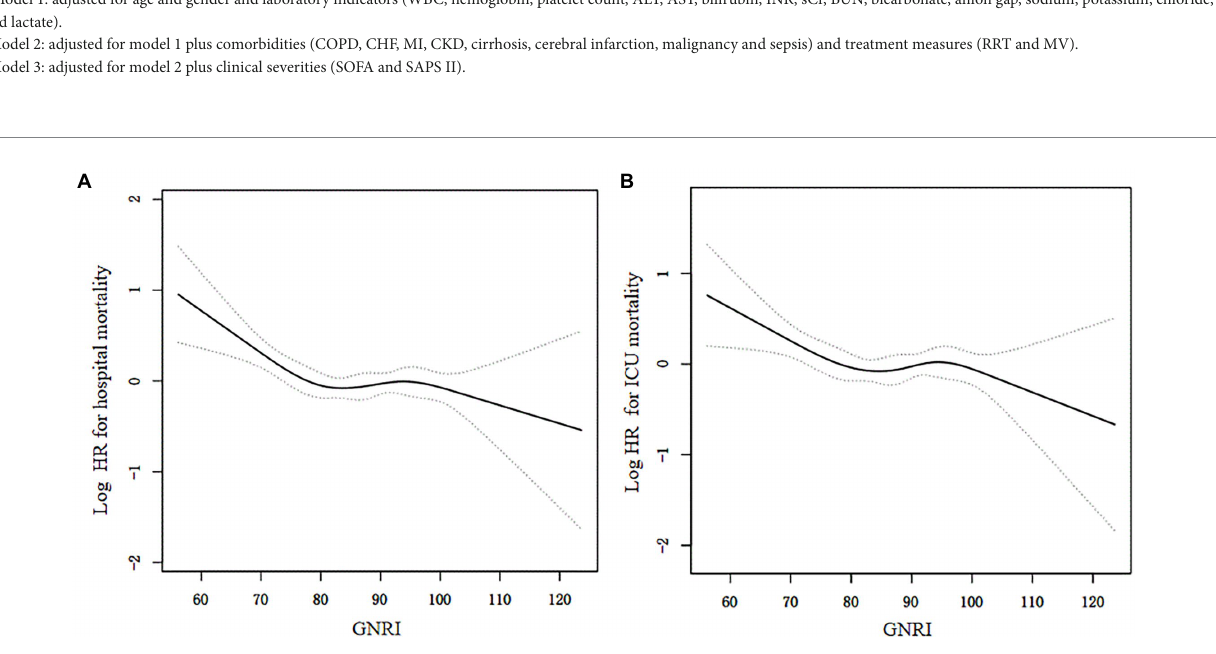
FIGURE 2 The associations of GNRI with hospital mortality (A) and ICU mortaltiy (B) by restricted cubic spline. The resulting figures showed the predicted log hazard ratios (HR) in the y-axis and the continuous levels of GNRI in the x-axis. The solid line represented the log hazard ratio and the dotted line was the 95% confidence interval (CI). HRs and associated 95% CIs were adjusted for variables in model